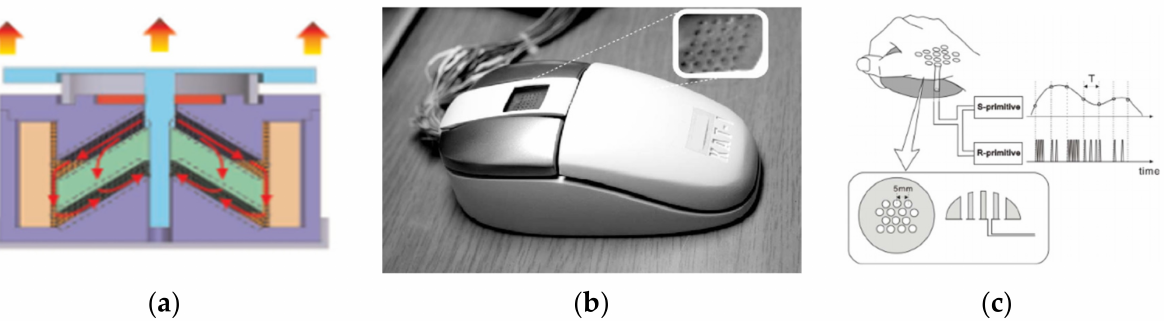
Figure 2. Various haptic devices. ( a ) Vibration using actuator ( b ) Texture stimulating mouse ( c ) Air Injection and Inhalation